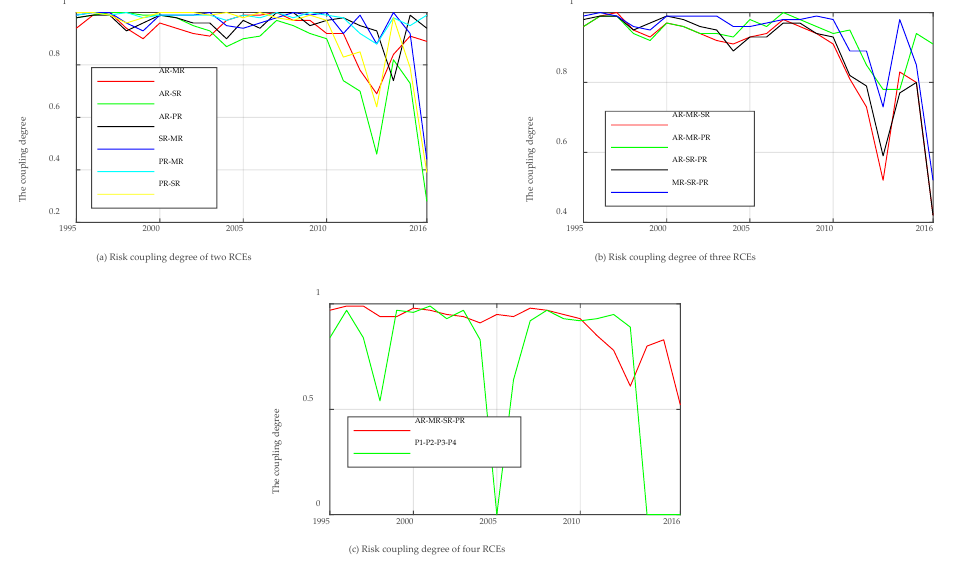
Figure 10. The coupling degrees.